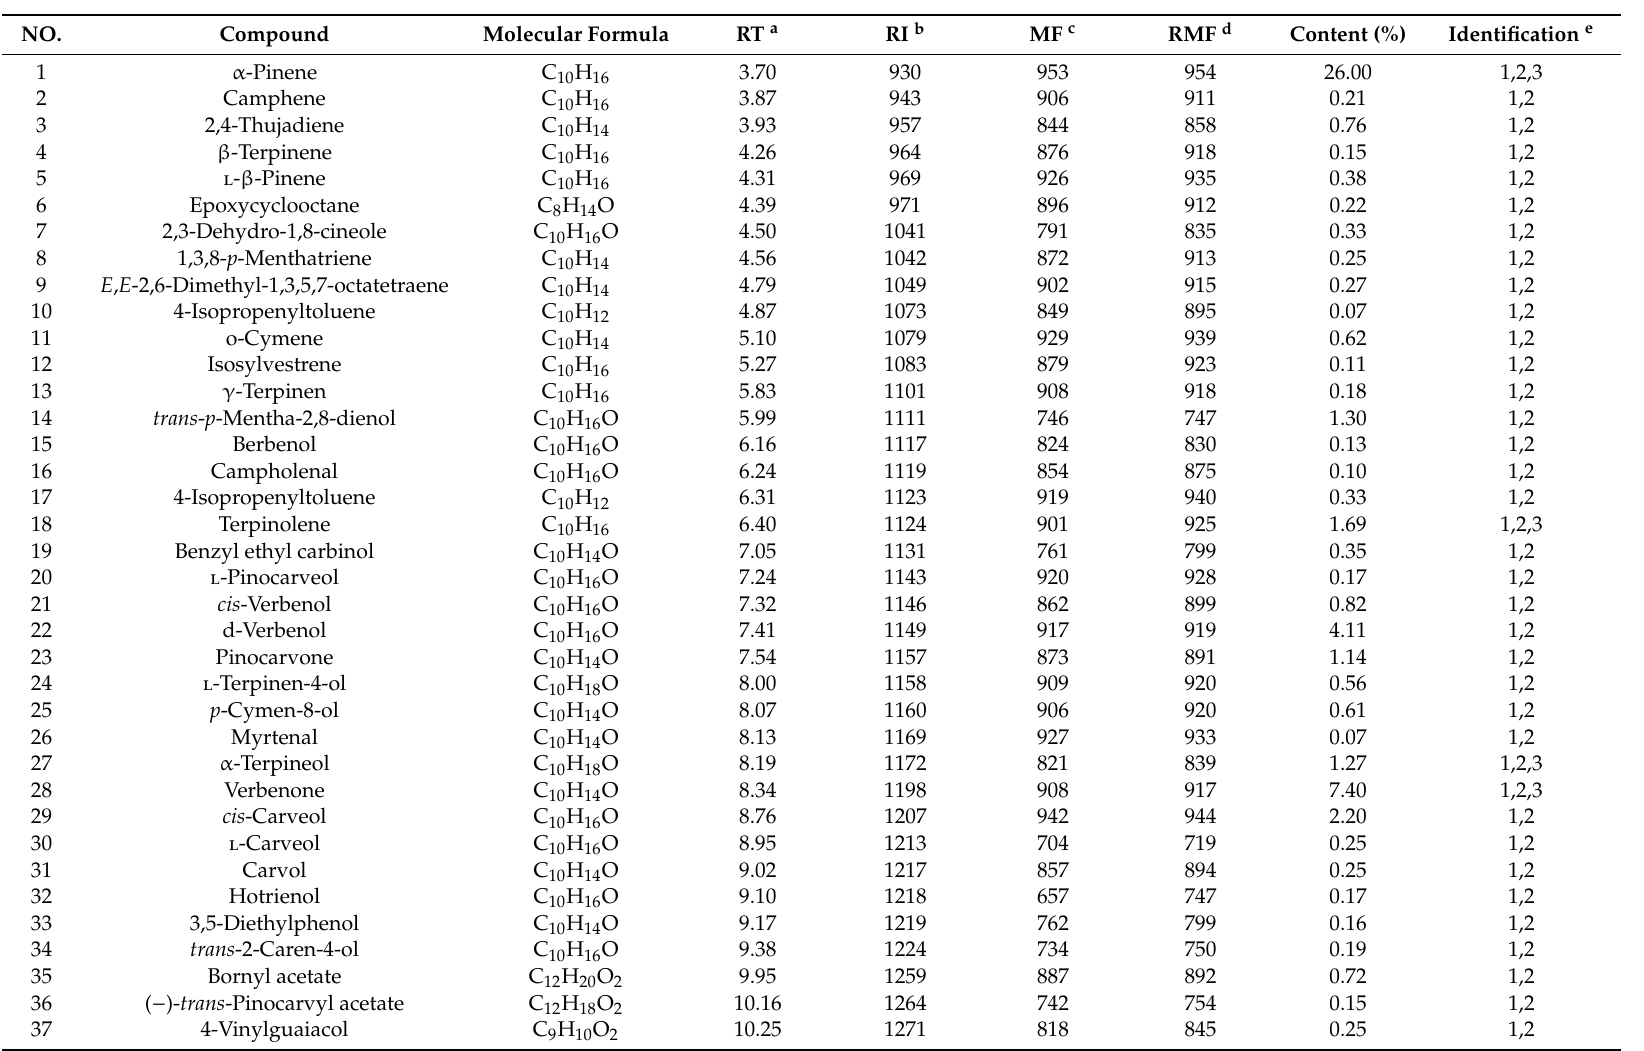
Table 1. Chemical composition of